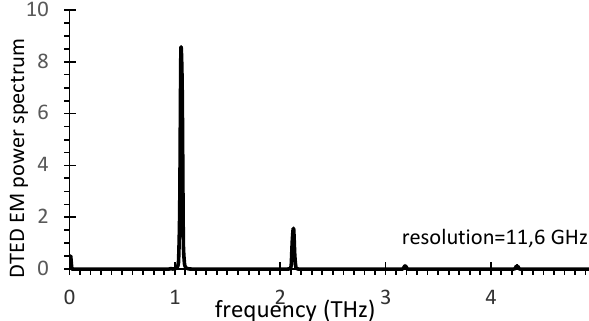
Figure 4: Frequency spectrum of output EM power under CW operation (L DTED = 88 µm, V DC = 9